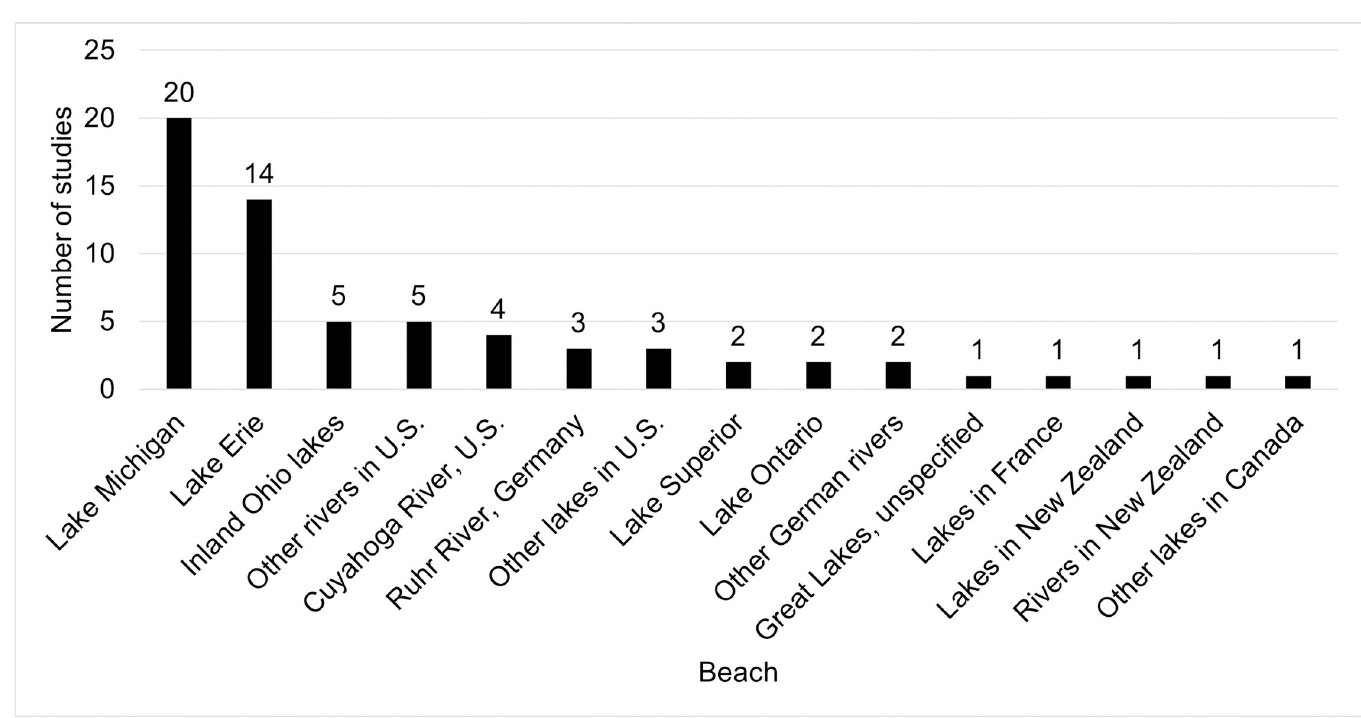
Fig 4. Frequency of the location of